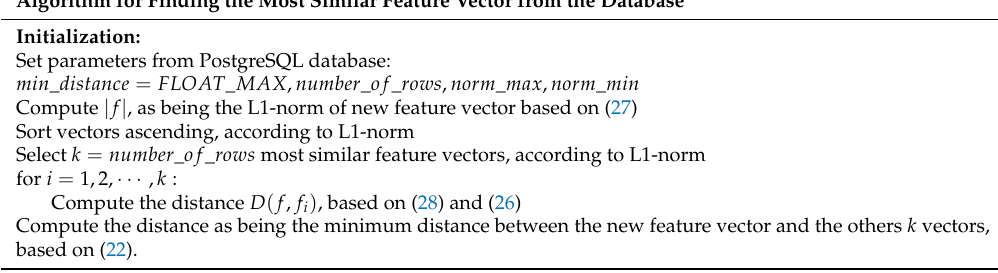
Table 5. Algorithm designed for